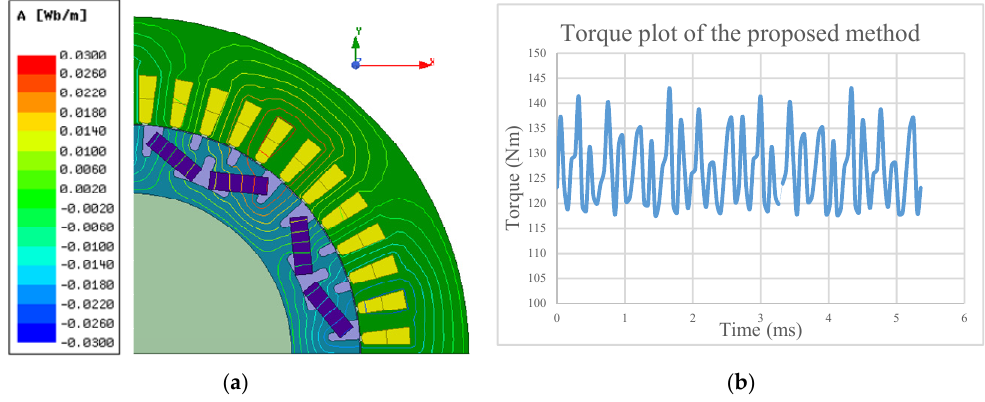
Figure 6. The Optimized design of IPM obtained by the proposed algorithm: ( a ) cross-section; and ( b ) torque plot.